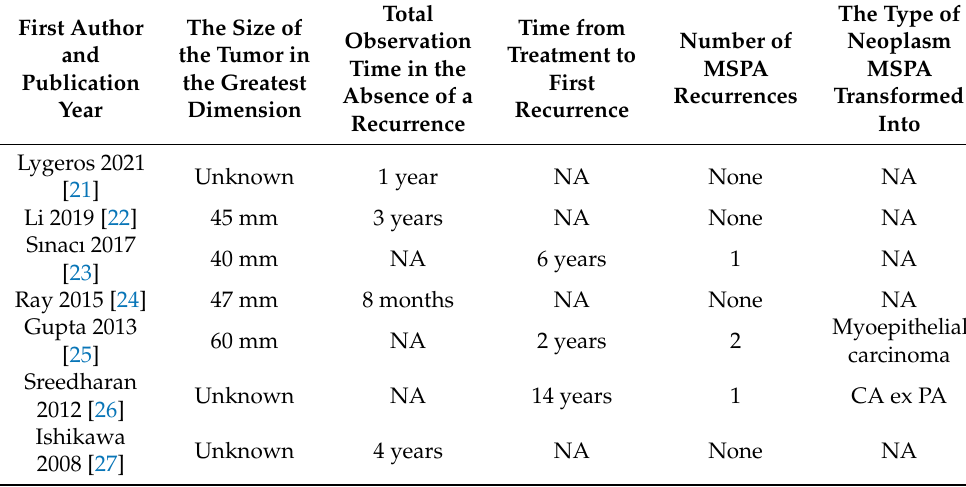
Table 8. Outcomes and other variables closely related to outcomes. NA—Not applicable; CA— Carcinoma; PA—pleomorphic